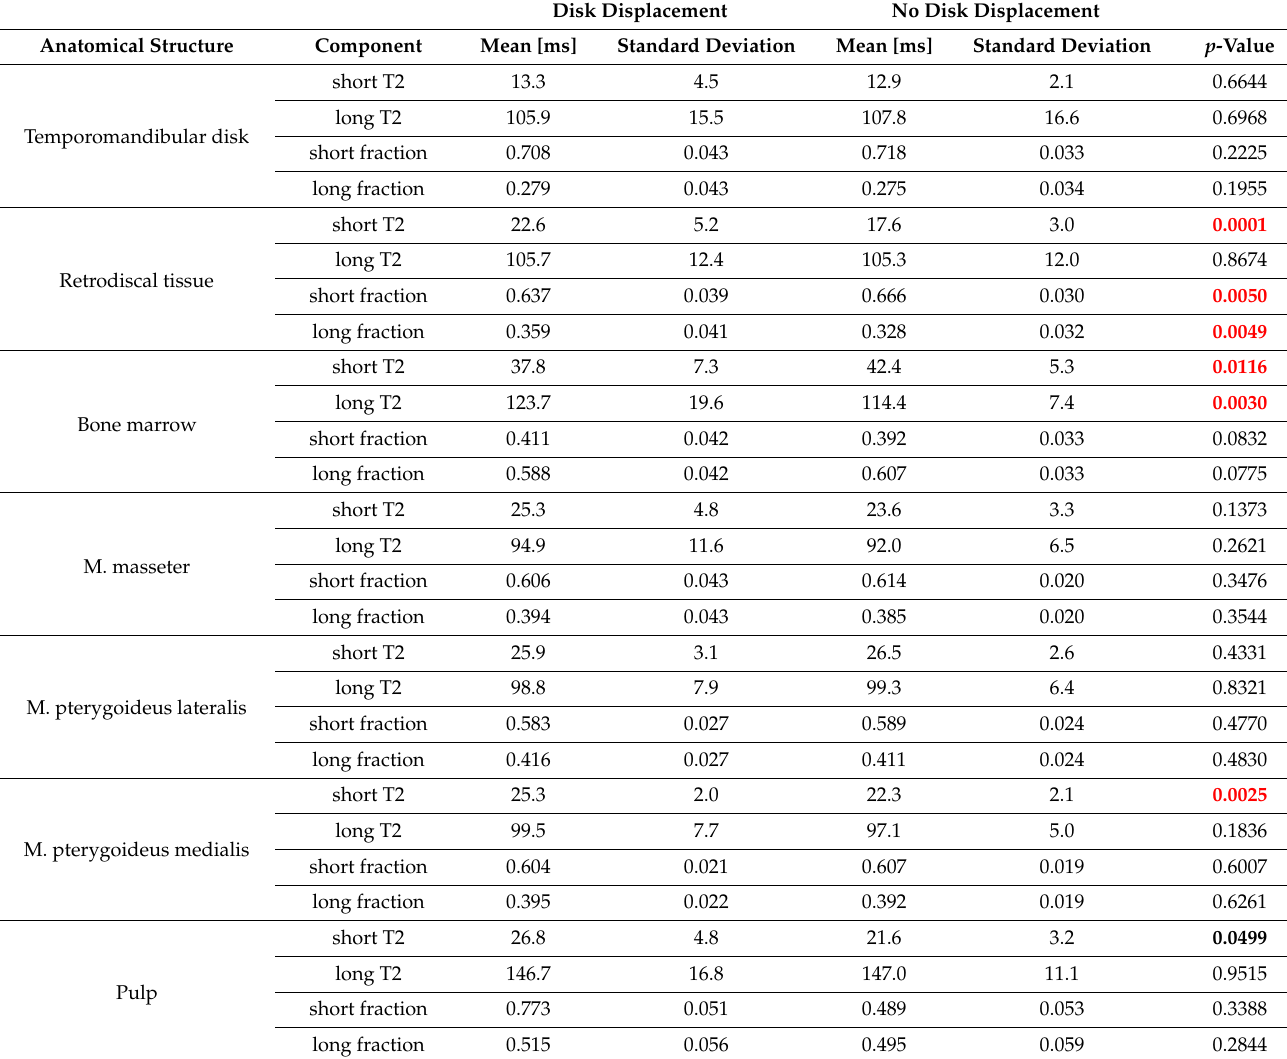
Table 2. Results of the studies. The bolded values show the tendency to significance. The colored and bolded indicate the significant values. Disk Displacement No Disk